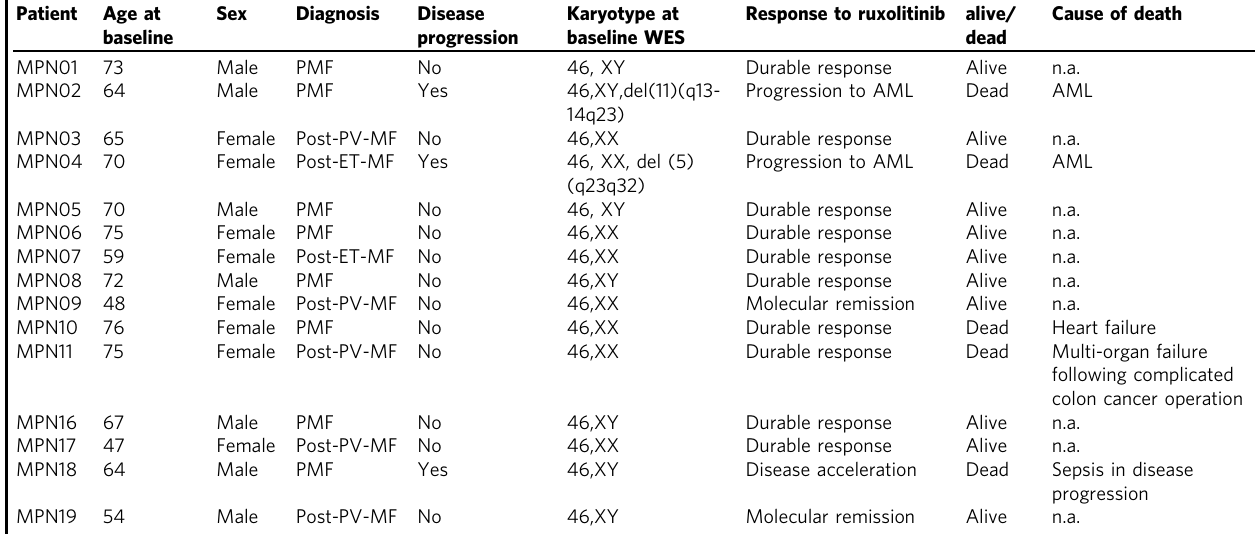
Table 1 Baseline characteristics of the 15 investigated myelo fi brosis